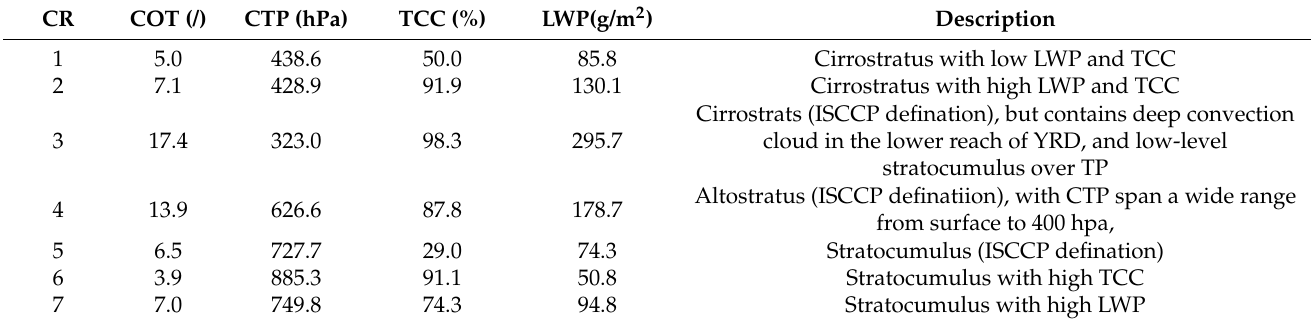
Table 1. The mean cloud properties and description for each regime.